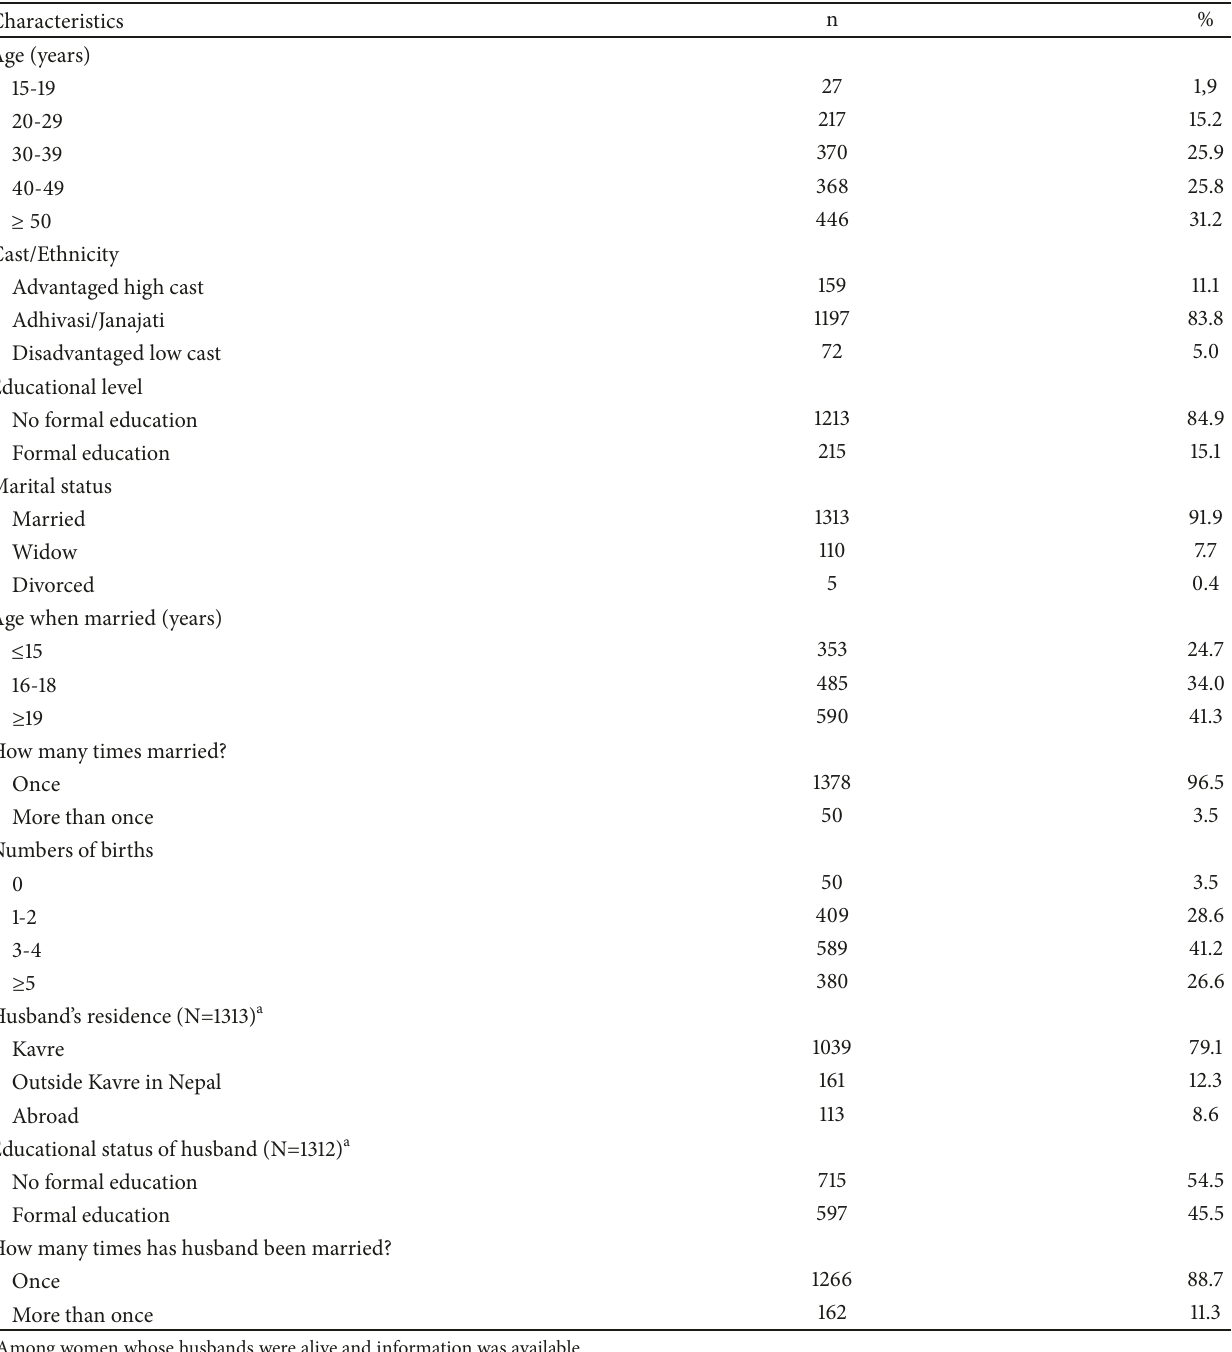
Table 1: Characteristicsof participants in a population-based study of sexually transmitted infections (STIs) among women from rural Nepal